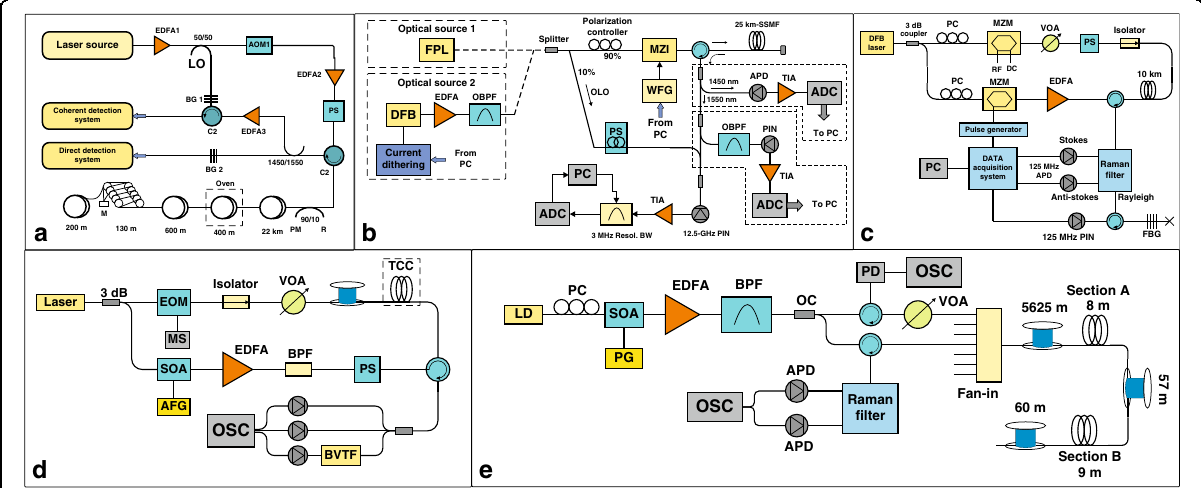
Fig. 11 Experimental setup and results based on dual-parameter sensing. a Combined Brillouin and Raman scattering sensing, ( b ) hybrid Raman and Brillouin scattering sensing based on standard Fabry – Perot lasers in conjunction with optical pulse coding techniques, ( c ) hybrid Raman/ Brillouin optical time-domain analysis of optical fi ber sensors, ( d ) hybrid quasi-single mode operated Raman-Brillouin system in few mode fi bers, ( e ) hybrid optical fi ber sensor combined with the Raman optical fi ber sensing and phase-sensitive optical time-domain re fl